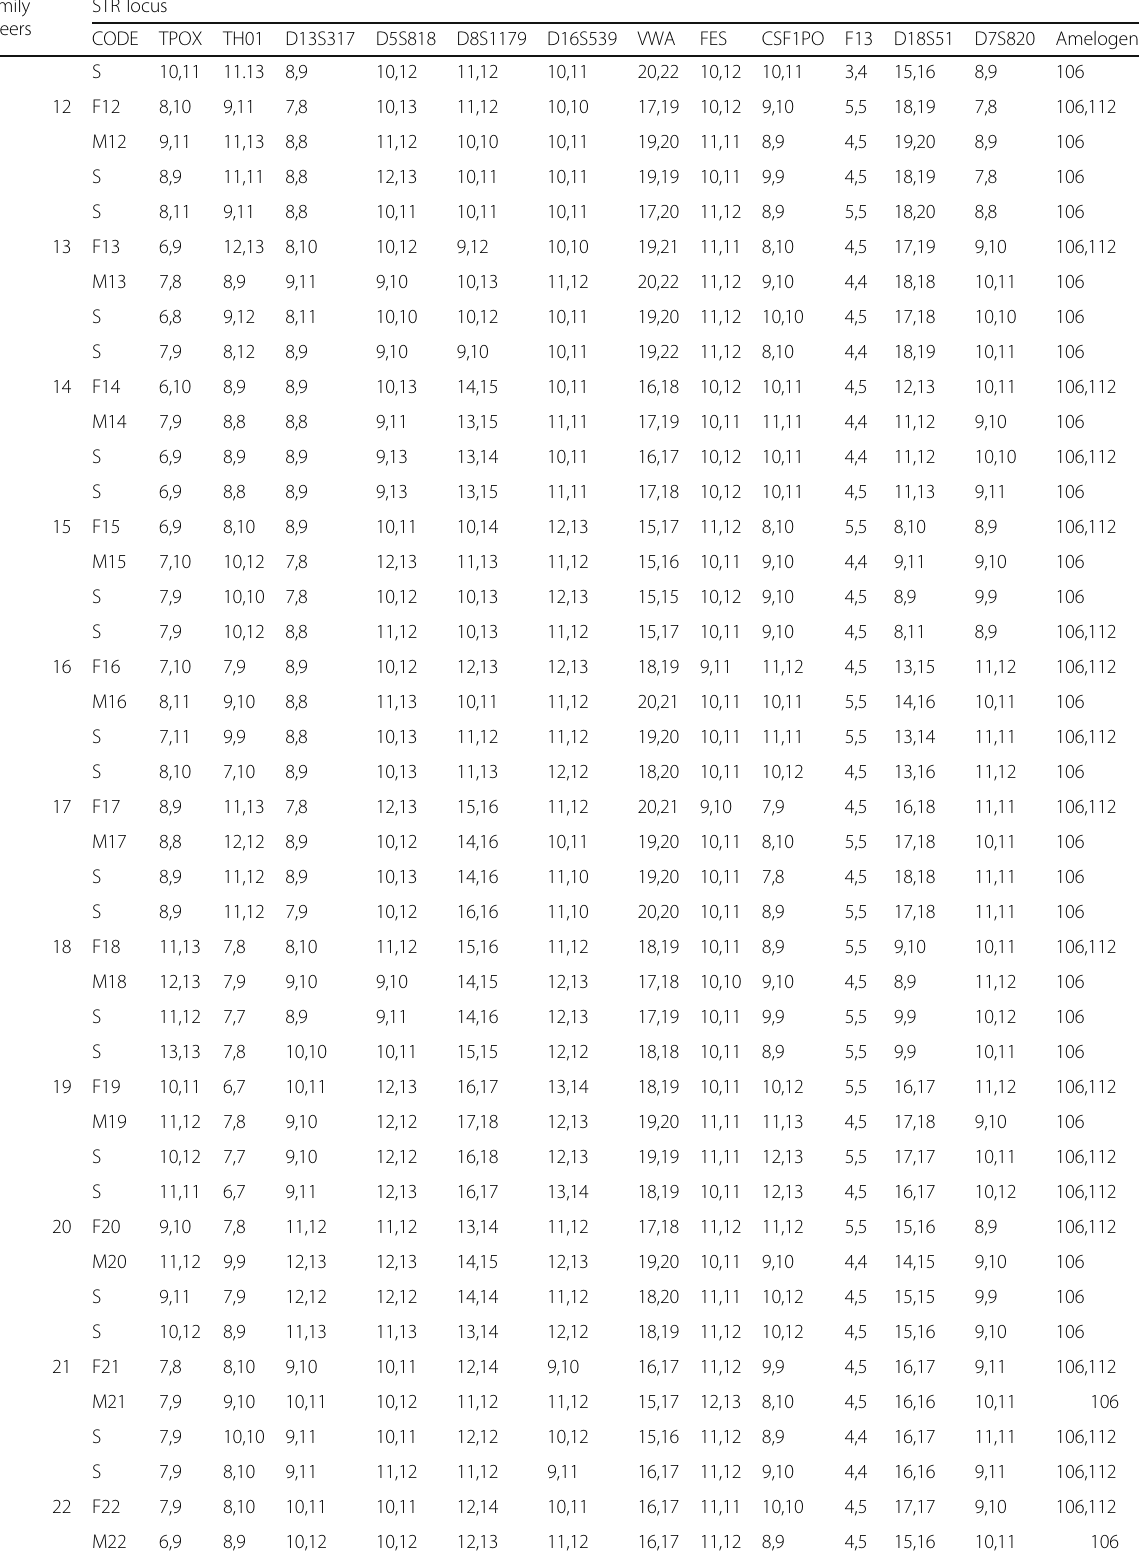
Table 1 Autosomal STR allelic genotype and amelogenin of the 25 full sibling pairs (Continued) F25 family STR volunteers